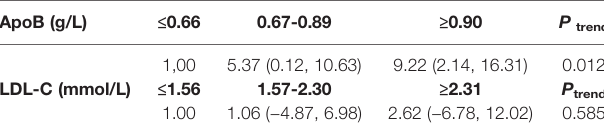
TABLE 2 | B (95%CIs) for the levels of apoB and LDL-C. ApoB (g/L) ≤ 0.66 0.67-0.89